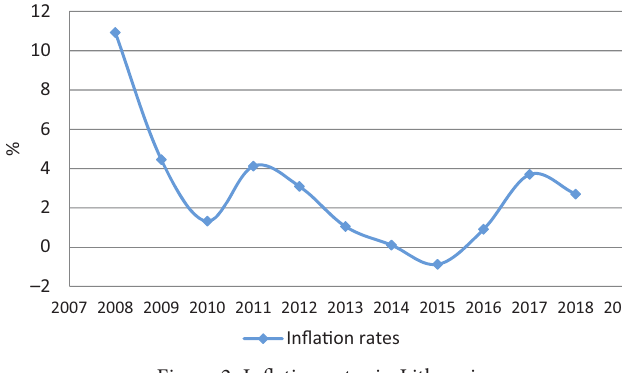
Figure 2. Inflation rates in Lithuania (source: BIS, 2019b; European Central Bank, 2019; LB,